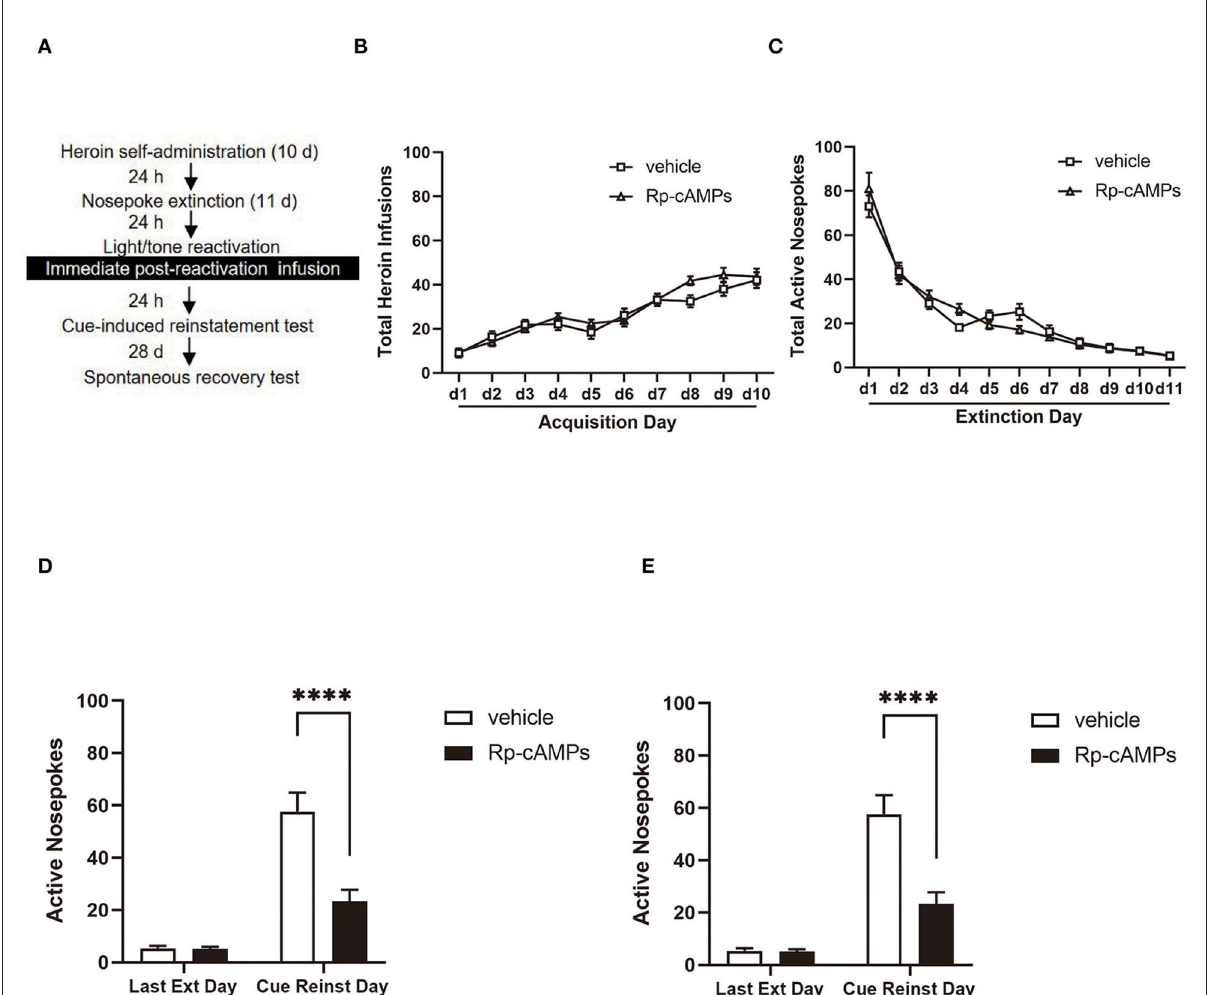
FIGURE2 The effect of immediately post-reactivation intra-BLA PKA inhibition on cue-induced reinstatement and spontaneous recovery test 28 days later. (A) Timeline of the experimental procedure. (B) The total number of infusions during the acquisition of heroin self-administration. (C) The total number of active nosepoke responses during extinction sessions. (D) Active nosepoke responses during the last day of extinction and the cue-induced reinstatement test. (E) Active nosepoke responses during the last extinction day and the spontaneous recovery test. The value of n = 9 rats per group. Data are means ± SEM, **** p < 0.0001, compared with the vehicle group. Ext, extinction; Reinst, reinstatement; SR, spontaneous